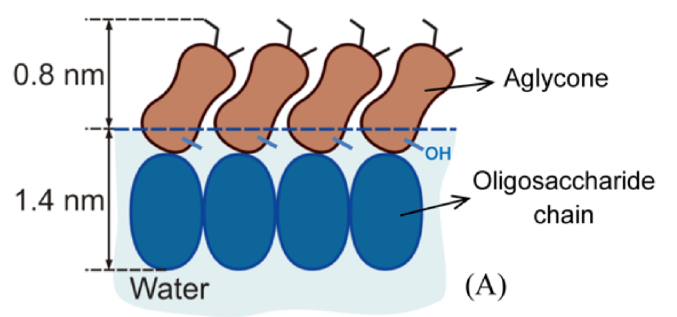
Figure 6. Schematic of the proposed orientation of densely packed β -aescin molecules at the water–air interface, as determined from NR experiments. Reprinted with permission from Penfold et al. [38], ©2018 American Chemical